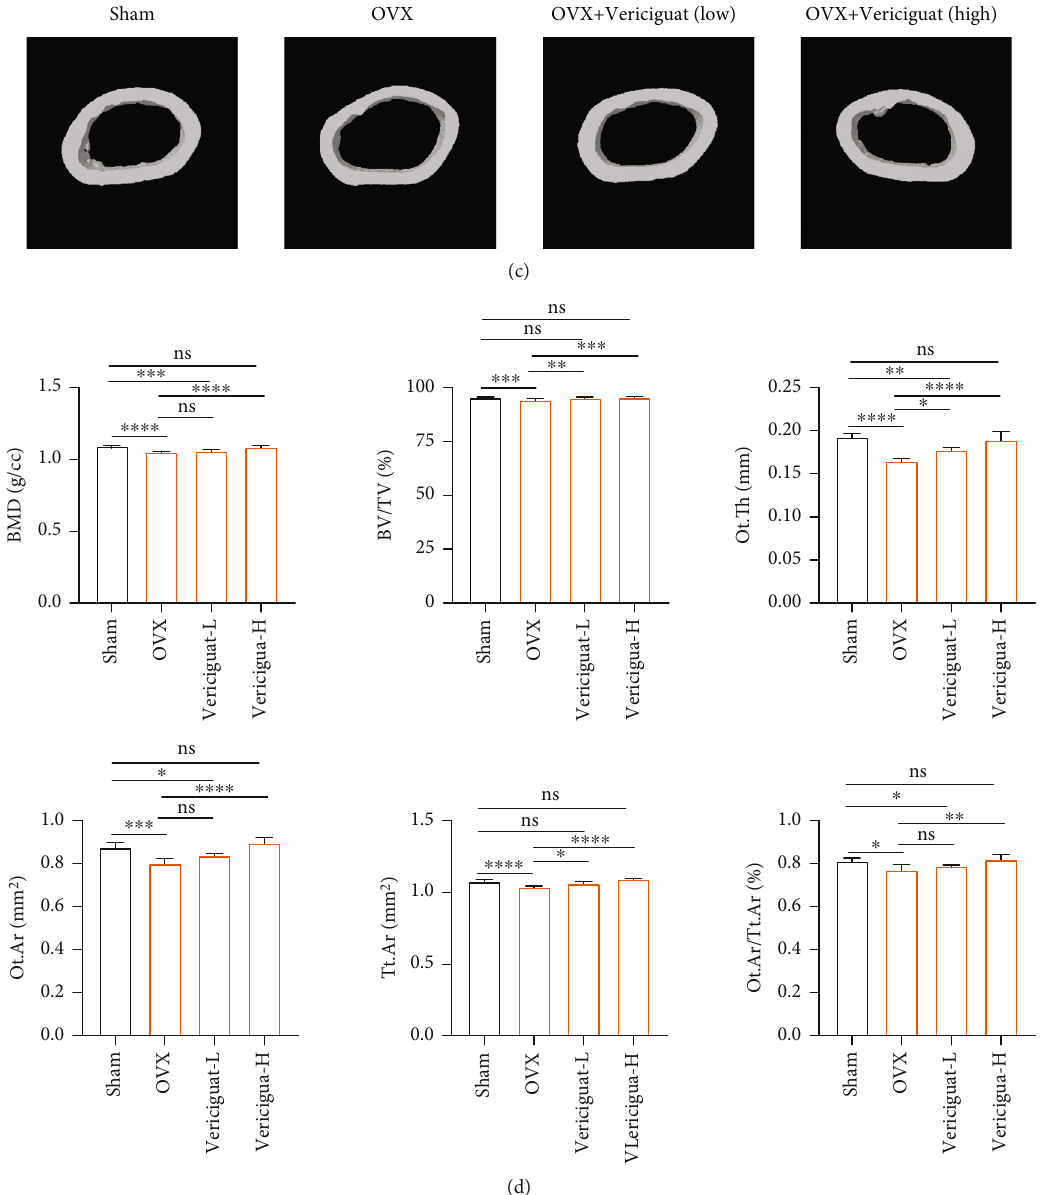
Figure 9: Validation of the e ff ects of Vericiguat on OVX-induced bone loss in vivo indicated by microstructure analysis. (a) Representative 3-dimensional images of μ CT for mouse femur from the sham group (mock operation with DMSO injection), OVX group (OVX with DMSO injection), low-dose group (OVX with low-dose Vericiguat, 5 μ g/kg/day), and high-dose group (OVX with high-dose Vericiguat, 10 μ g/kg/day) ( n = 5 ). (b) Quantitative results of bone structural parameters, including trabecular bone mineral density (BMD, g/cc), bone surface area/total volume (BS/TV; %), bone volume/total volume (BV/TV; mm − 1 ), trabecular number (Tb.N; mm − 1 ), trabecular spacing (Tb.Sp; mm), and trabecular thickness (Tb.Th; mm) within the selected metaphyseal region ( n = 5 ). (c) Representative 3- dimensional images of μ CT for the mouse femur (cortical bone) from di ff erent groups above. (d) Quantitative results of bone structural parameters, including cortical bone mineral density (BMD; g/cc), bone volume/total volume (BV/TV; mm − 1 ), total cross-sectional area inside the periosteal envelope (Tt.Ar; mm 2 ), cortical bone area (Ct.Ar; mm 2 ), cortical area fraction (Ct.Ar/Tt. Ar; %), and average cortical thickness (Ct.Th; mm). ∗ indicated a comparison with the sham group: ∗∗∗ p < 0 : 001 and ∗∗∗∗ p < 0 : 0001 . # indicated a comparison between the VEGT-L/H group and OVX group at the same concentration of Vericiguat: ## p < 0 : 01 , ### p < 0 : 001 , and #### p < 0 : 0001 . ns: not statistically signi fi